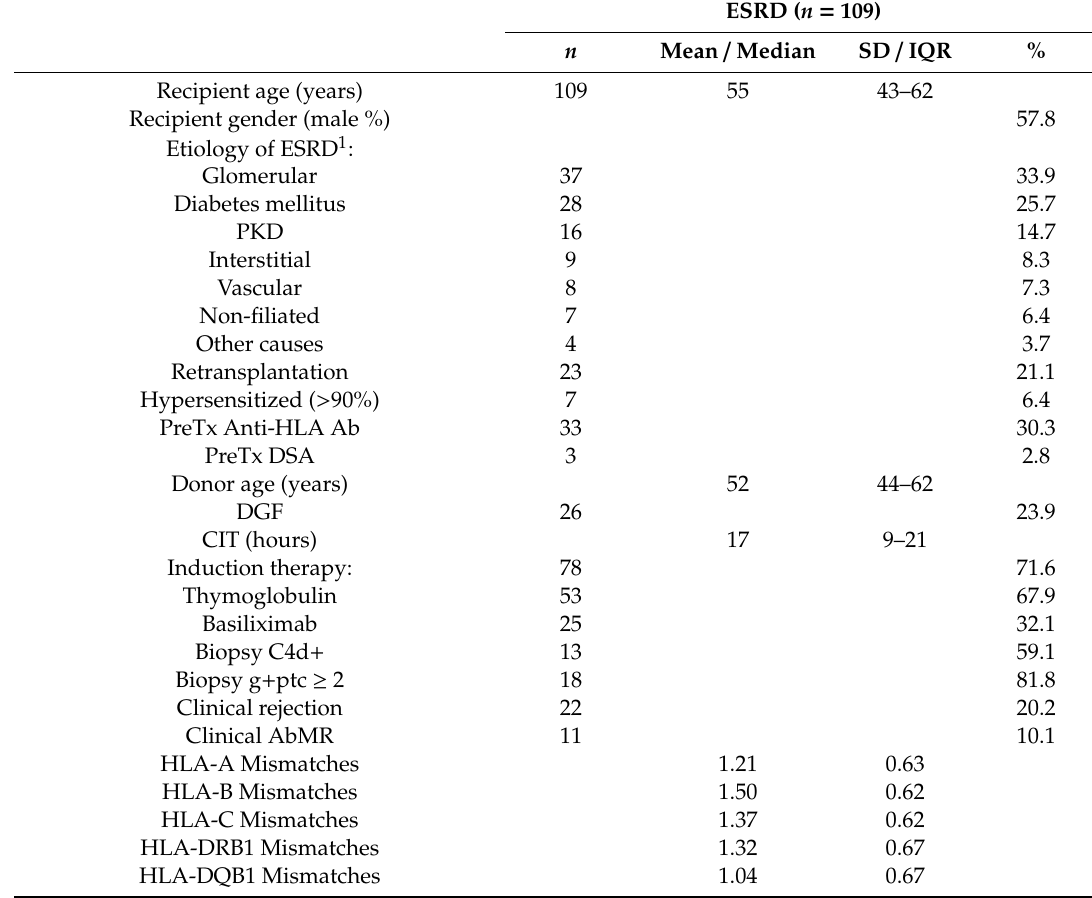
Table 1. Demographic, clinical, and immunological parameters of kidney transplant